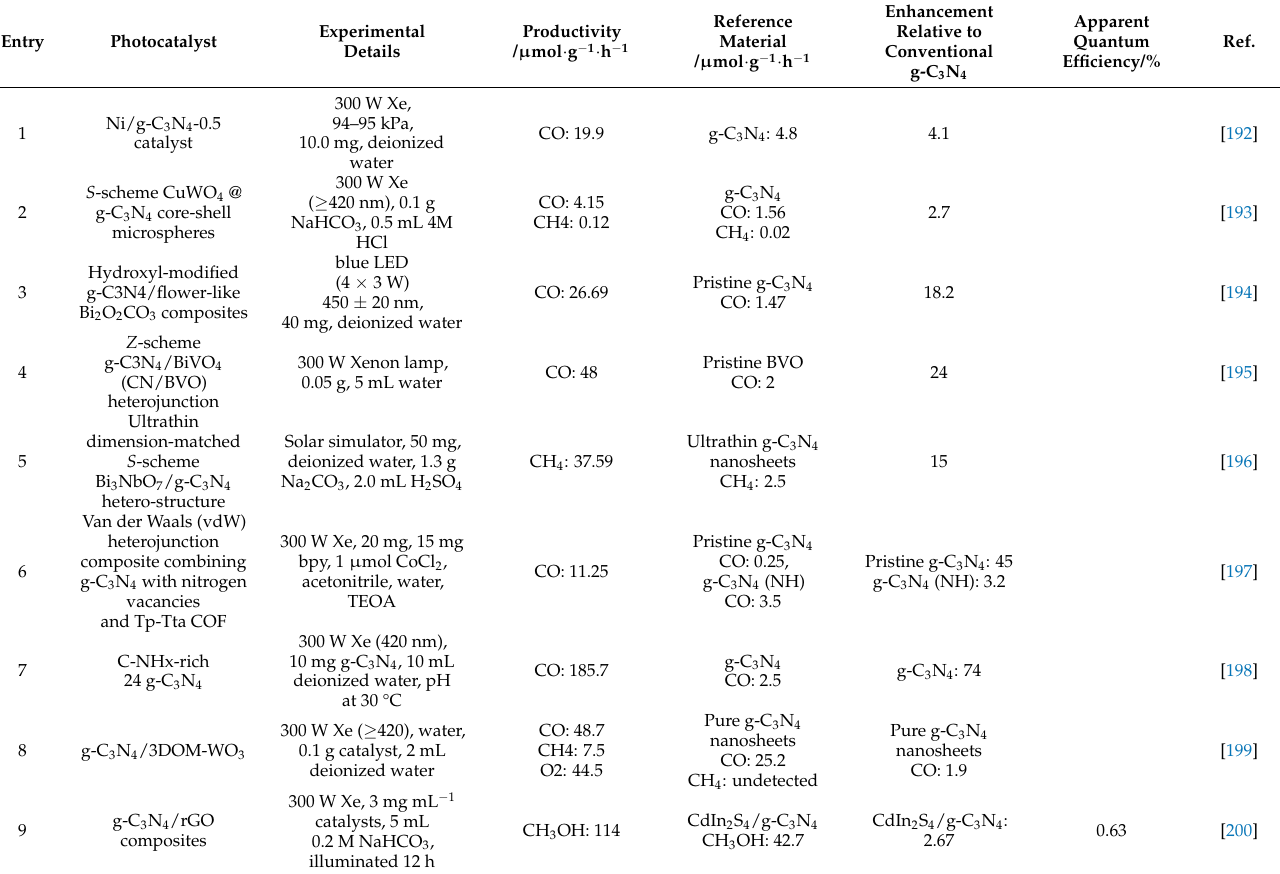
Table 2. Photocatalytic CO 2 reduction over g-C 3 N 4 -based